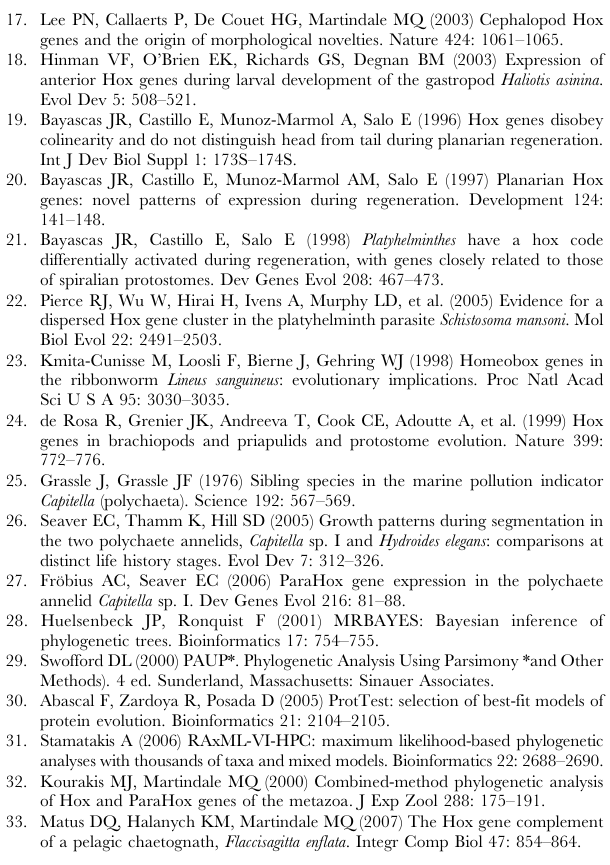
Figure S2 Neighbor-joining bootstrap consensus tree. A neigh- bor-joining (NJ) bootstrap consensus tree (using mean amino acid distances) was constructed using PAUP* v4.0b10 [29] with 1,000 iterations, using a 72-AA alignment of representative bilaterian Hox and Parahox genes (see Figure S1), including the 60-AA homeodomain as well as the 12 AAs immeditately flanking the 3 9 end of the homeodomain. Numbers above branches indicate NJ bootstrap support, shown as a percentage. New Capitella sp. I sequences are shown in bold; all Capitella sequences are delimited by an arrow. Figure S3 Maximum likelihood bootstrap consensus tree. A maximum likelihood (ML) bootstrap consensus tree was